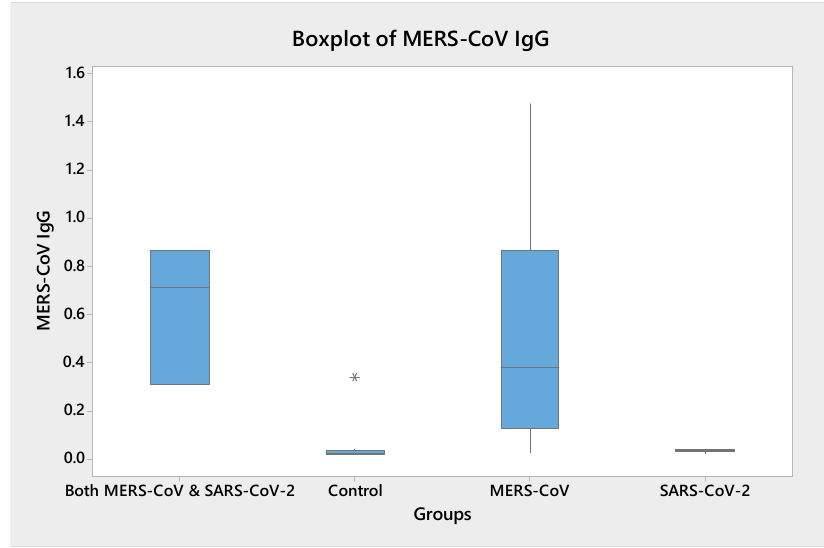
Figure 2. MERS-CoV Serology as Boxplot. Table 2. SARS-CoV-2 IgG and MERS-CoV IgG levels across the various groups.